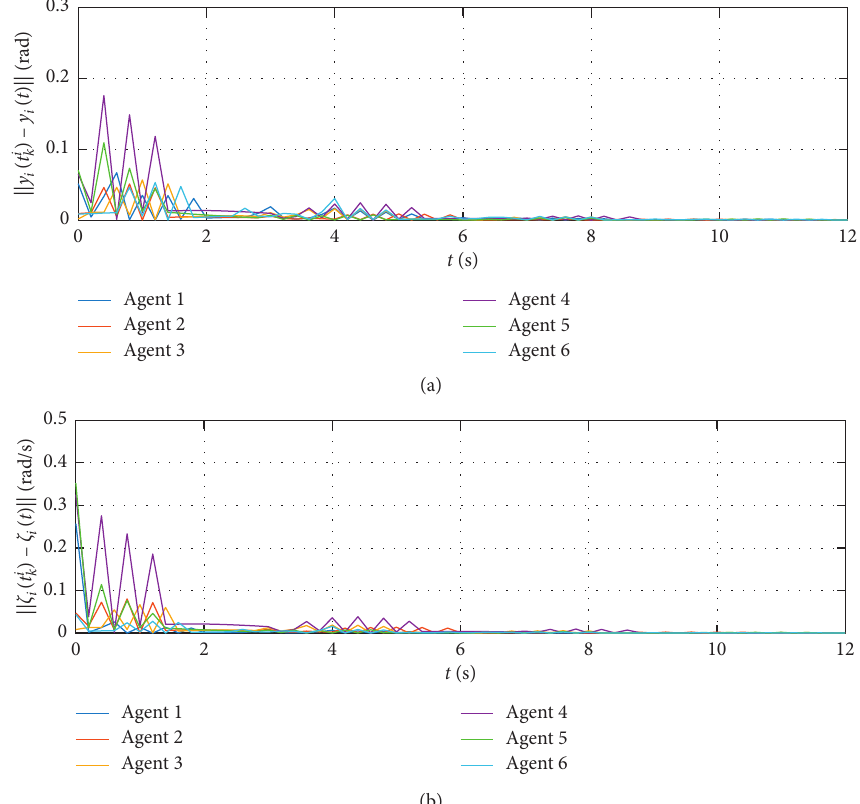
Figure 5: Simulation results of the fluttering of the measurement error. (a) The evolution of ‖ y h � 0 . 2s. (b) The evolution of ‖ ζ